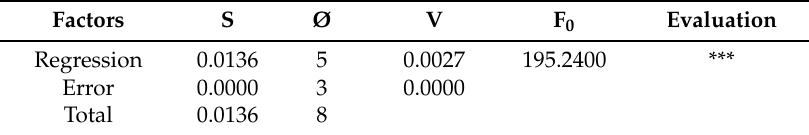
Table 10. Variance analysis for the density of recycled fine aggregate.